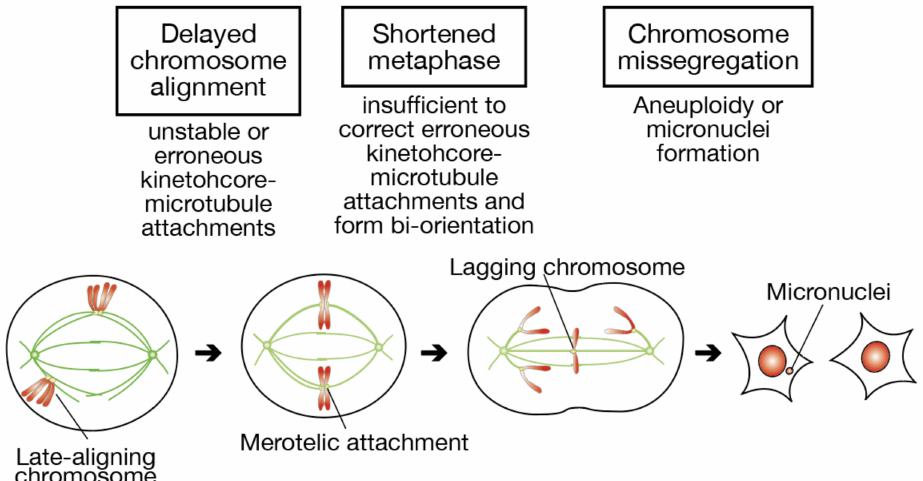
Figure 7. A schematic model depicting the relationship between delayed chromosome alignment and an increased rate of chromosome missegregation. When chromosome alignment is delayed, kinetochore-microtubule attachments of late-aligning chromosomes near spindle poles are unstable or might be erroneous. At the expense of elongated prometaphase, metaphase duration becomes shortened, which is insufficient for late-aligned chromosomes to correct erroneous kinetochore-microtubule attachments and form bi-orientation. Persistence of erroneous kinetochore-microtubule attachments at anaphase onset can result in chromosome missegregation such as the appearance of lagging chromosomes. A fraction of lagging chromosomes give rise to aneuploidy or micronuclei formation, causing genomic